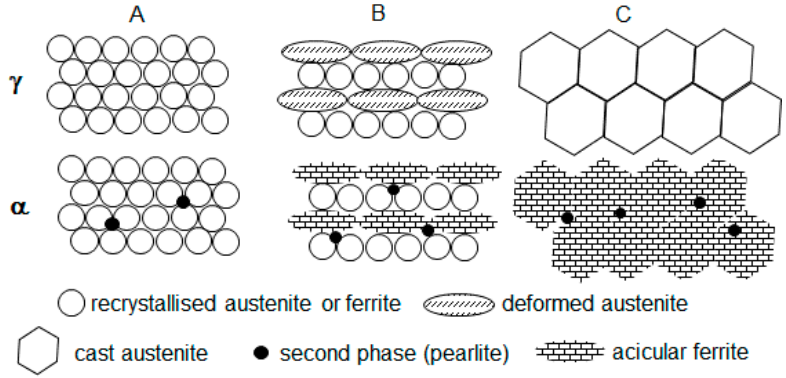
Figure 4. Schematic presentation of microstructure development in the Ti ‐ steel with processing route ( A – C ); γ : austenite temperature range, α : ferrite temperature range.